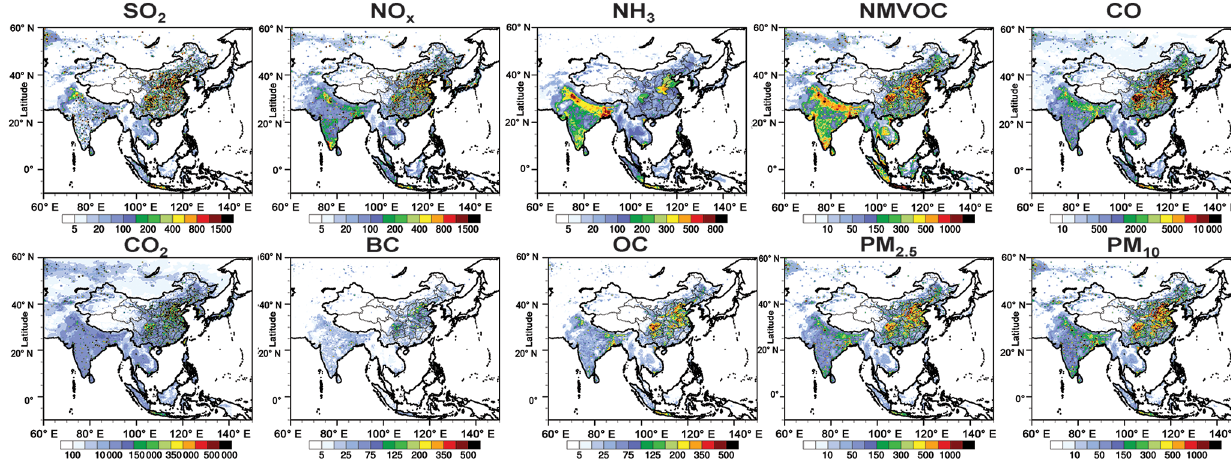
Figure 2. MIX emission inventory for January 2010 (Mgmonth − 1 grid − 1